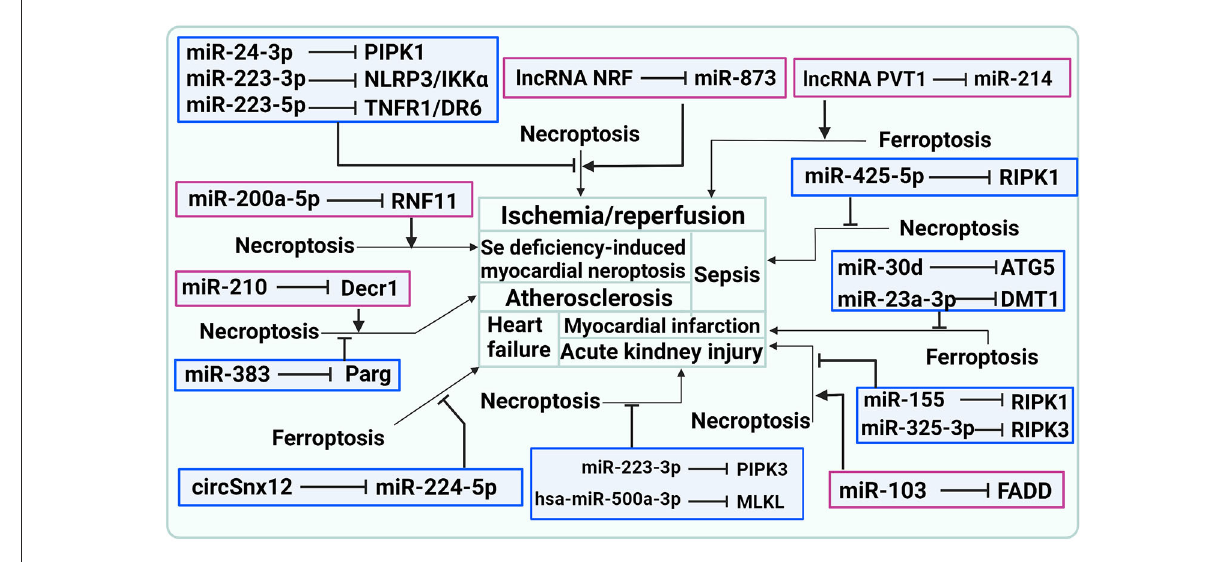
FIGURE2 ncRNAs are involved in CVDs by influencing the occurrence of necroptosis and ferroptosis.